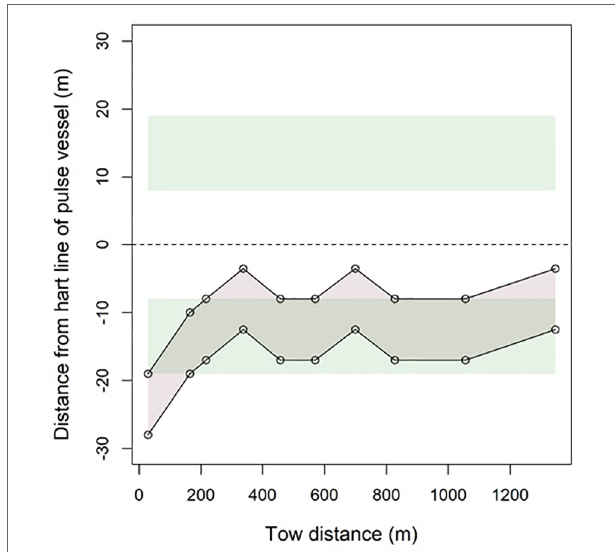
FIGURE 3 | Tracks of the starboard and port size pulse trawl (green) and reconstructed sampling track (grey) from the observed positions (o) of the shrimp trawl (o) of tow 1. The centerline of the pulse trawlers is positioned at 0 m on the